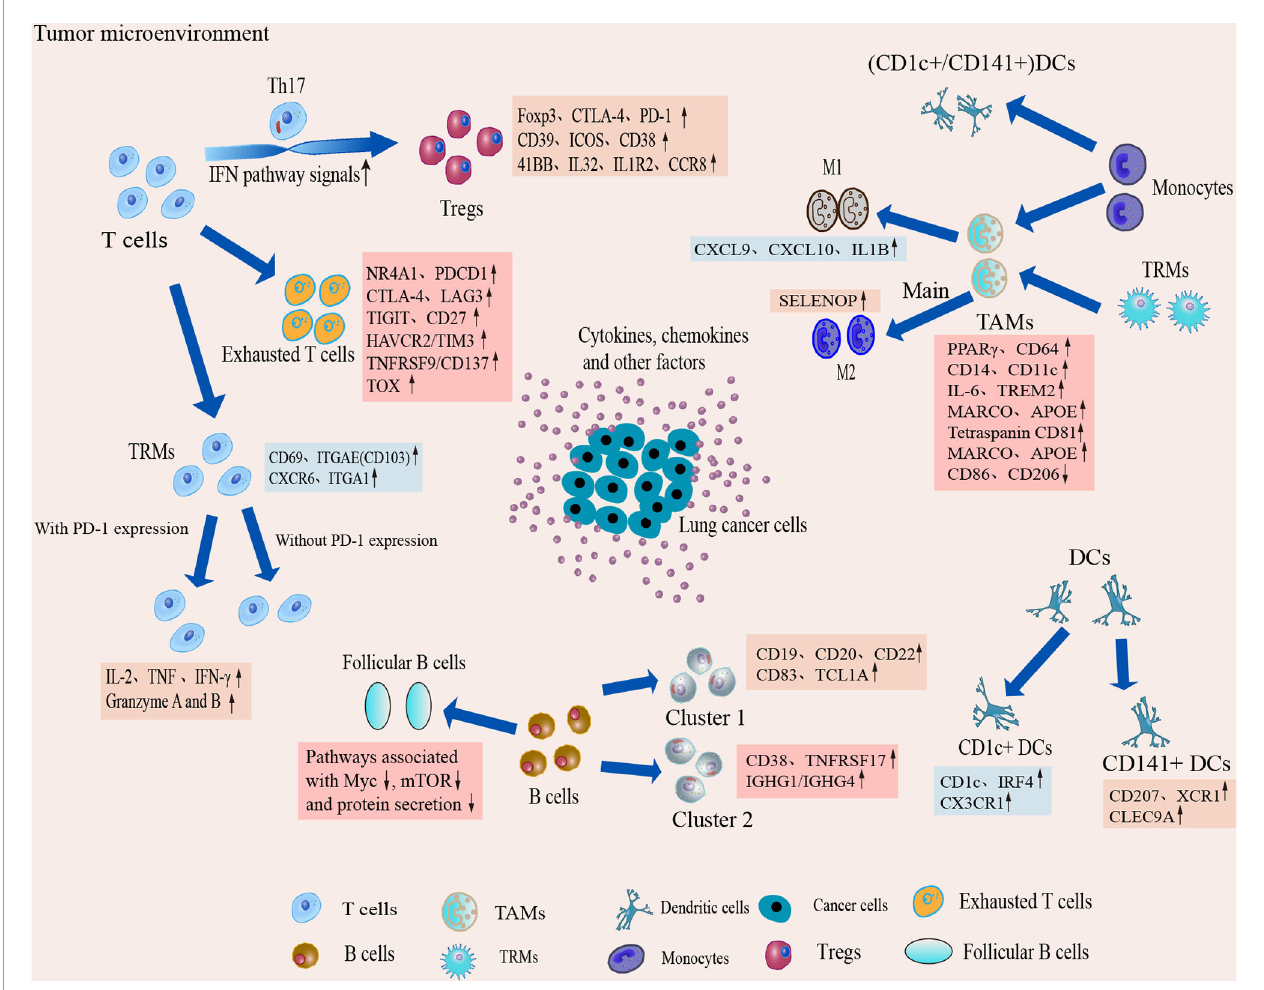
FIGURE 4 | Dynamic changes and transcriptional characteristics of IICs in the TME. Tumor-in fi ltrating T cells undergo phenotypic transitions and functional state shifts that drive the immunosuppressive microenvironment. Macrophages are predominantly differentiated from monocytes in the TME, and TME sculpts them into animmunosuppressive phenotype, leading to accumulation of suppressive TAM and a tendency to differentiate toward M2. Single-cell interrogation helps identify novel subpopulations of TAM in TME and reveals that TAM subtypes tend to co-express M1 and M2 features. B cells play an important role in antitumor immunity and ICI therapy, but the B cells show heterogeneous subpopulations and reduced follicular B cell function in the TME. Two classical subgroups of DCs also show heterogeneous expression in the TME, which suggests that DCs can induce immune tolerance in the